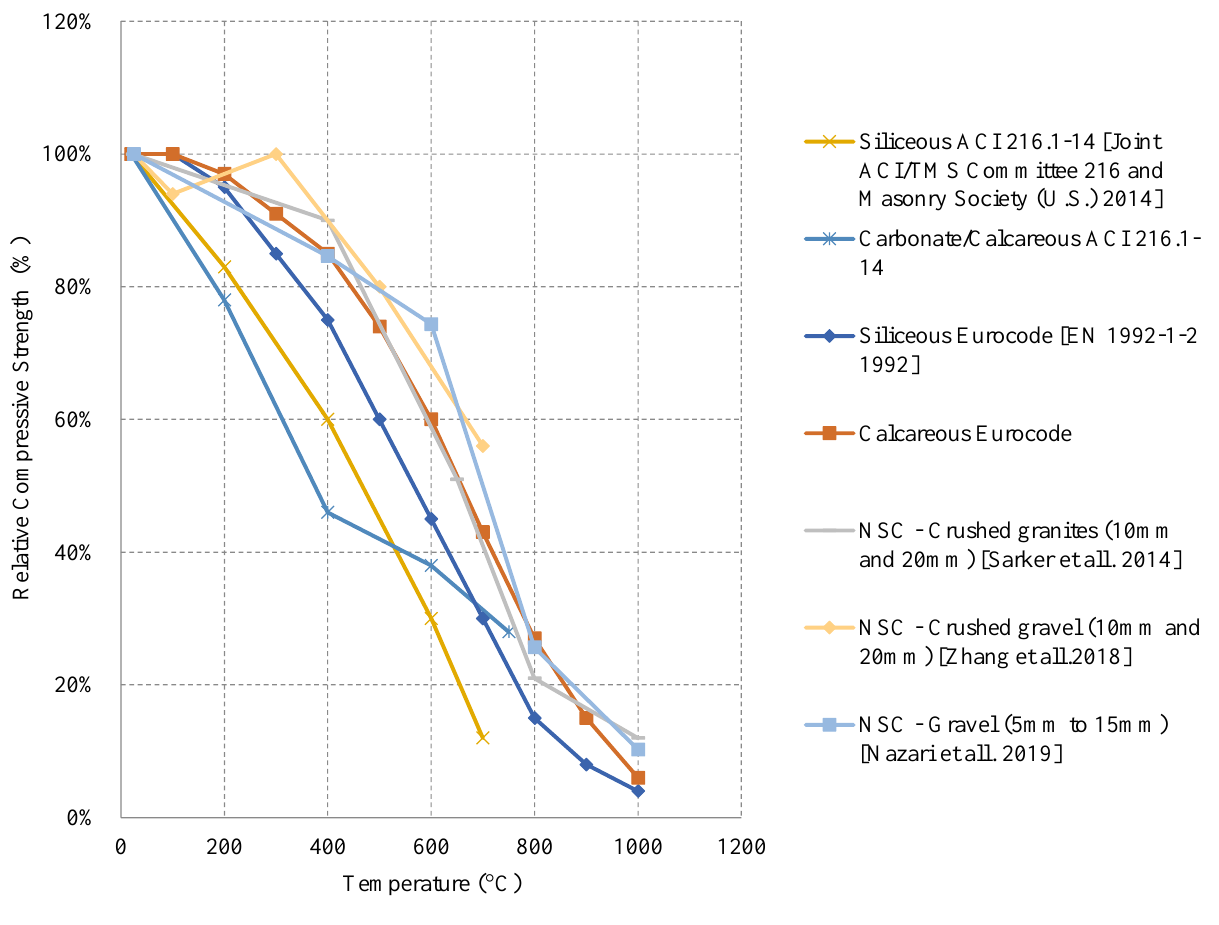
Figure 5. Effect of different constituents on the relative compressive strength of naturally cooled NSC [4,5,39,43,44].